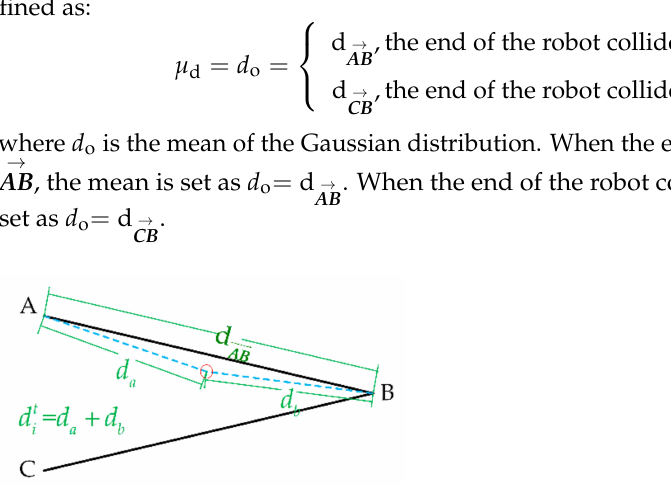
Figure 3. Probabilistic model based on the position information. The solid black line indicates the uncertain operating object and the red circle indicates the end of the